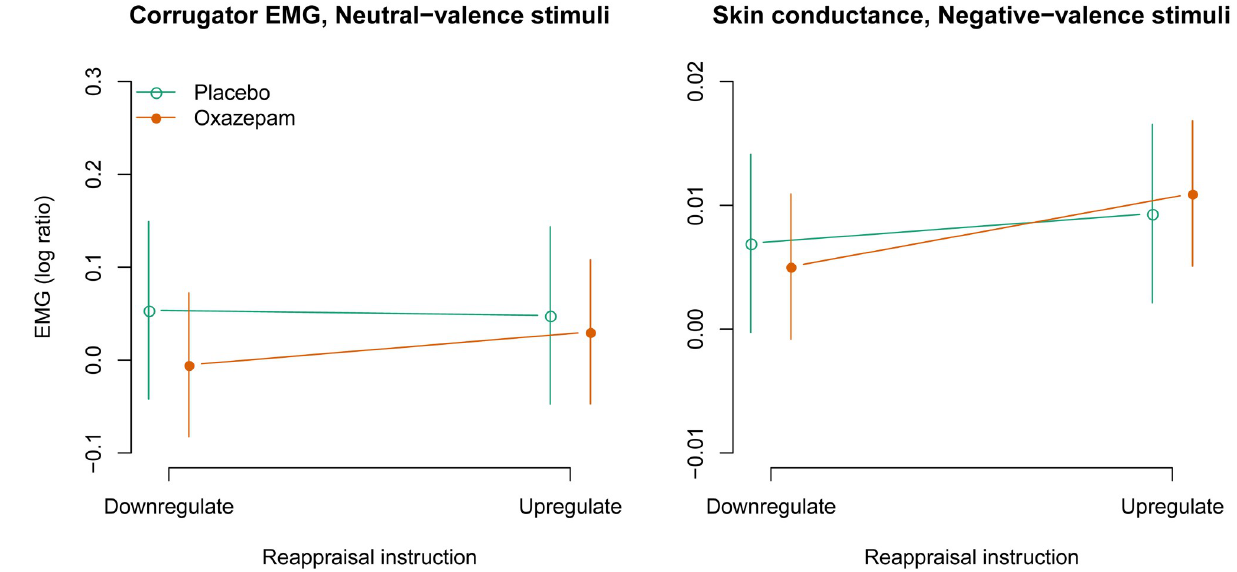
Fig 6. Corrugator EMG responses: Model estimates with 95% confidence